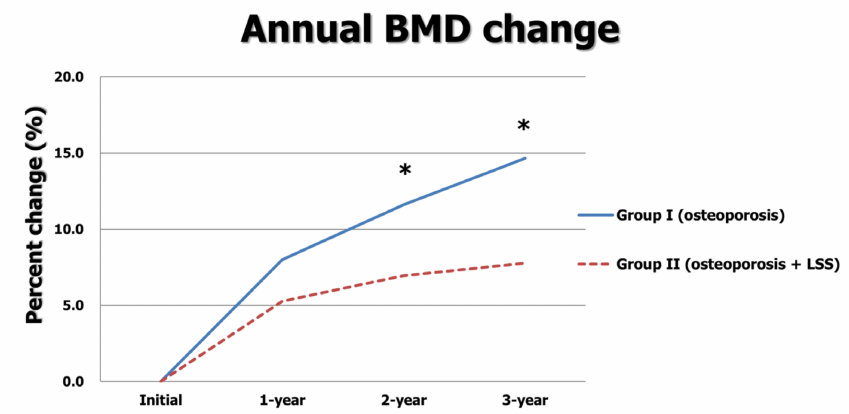
Figure 2. Annual BMD changes between two groups. * indicates p <